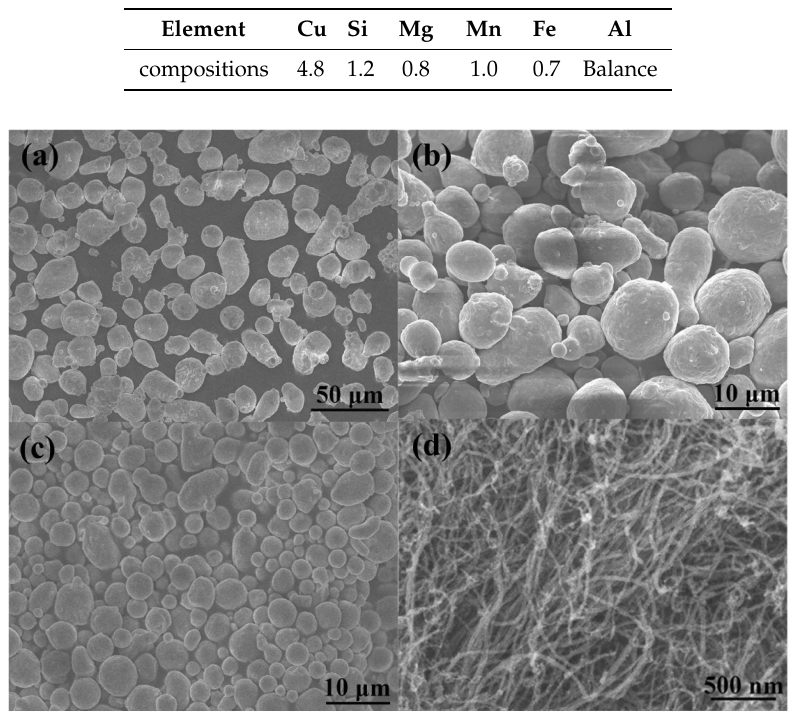
Table 1. Chemical compositions of the 2014 Al matrix (wt